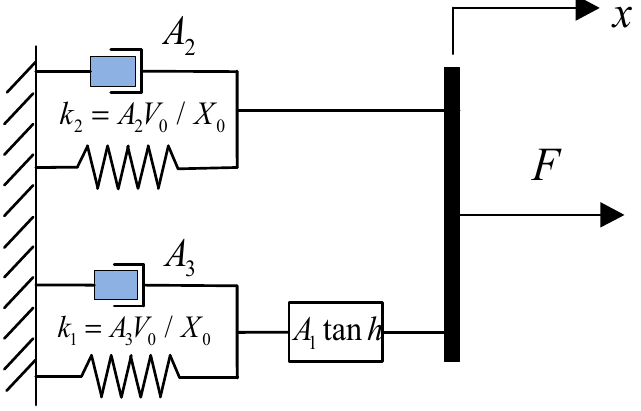
Figure 3. Improved hyperbolic tangent model.